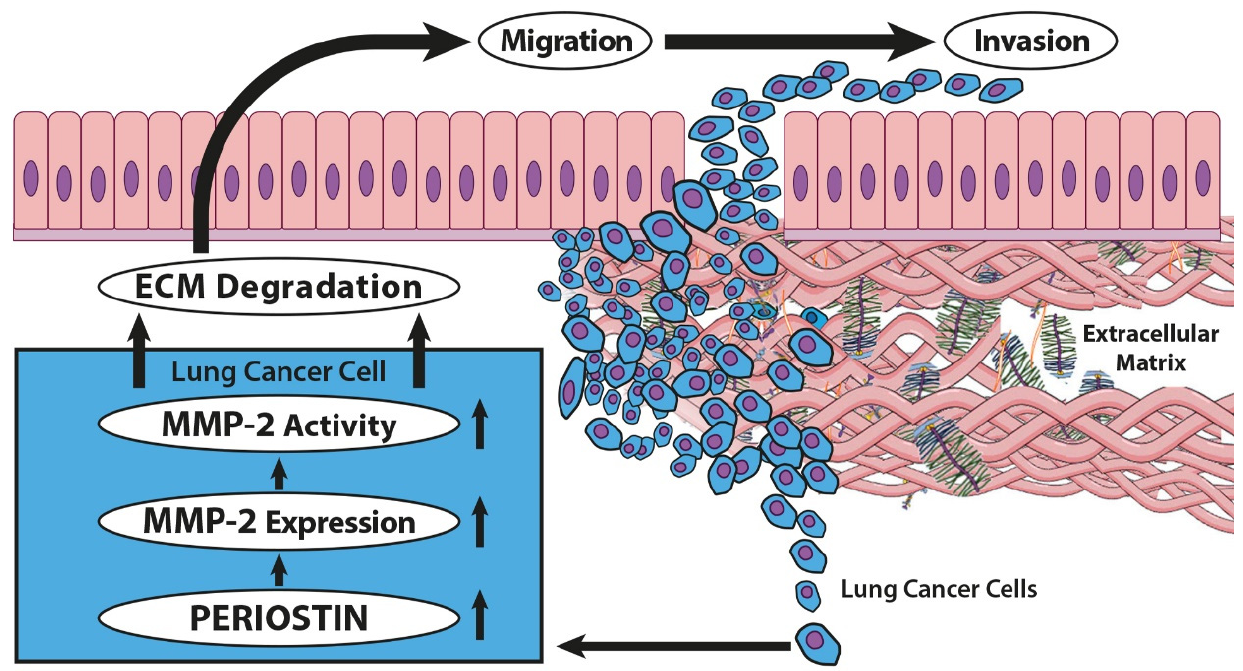
Figure 14. Schema of the signaling pathway involved in the invasion of lung cancer. POSTN might regulate lung cancer cell invasiveness by modulating the expression and activity level of MMP-2, a protein acting as a metastasis-associated factor of the tumor microenvironment, which serves an important role in the degradation of the basement membrane and the invasion of cancer cells. The figure is based on Cui et al. [56], modified.